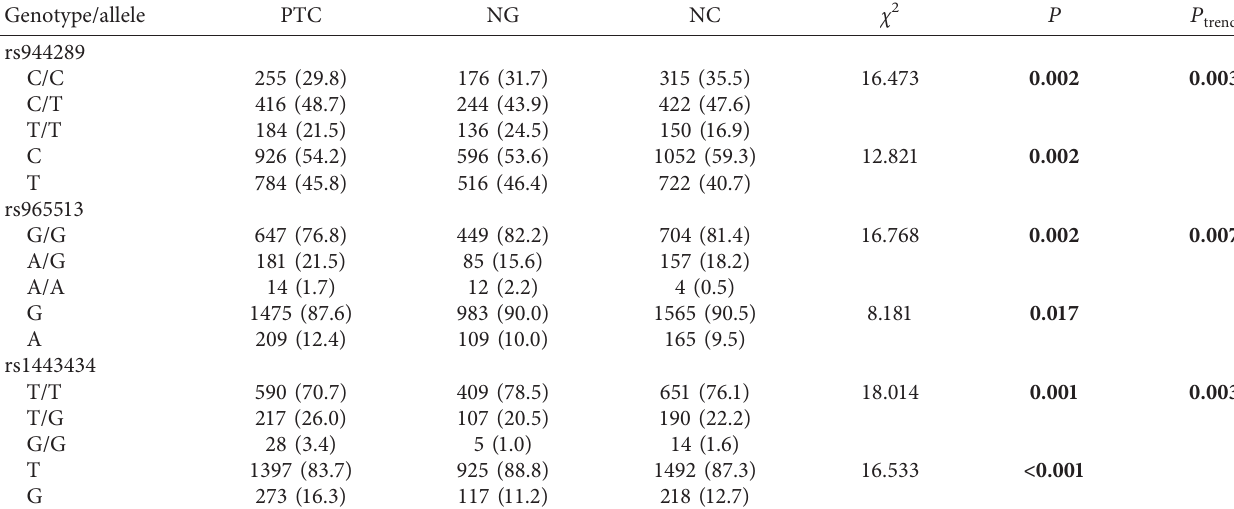
Table 2: Genotype and allele distributions of the three SNPs in PTCs, NGs, and NCs.